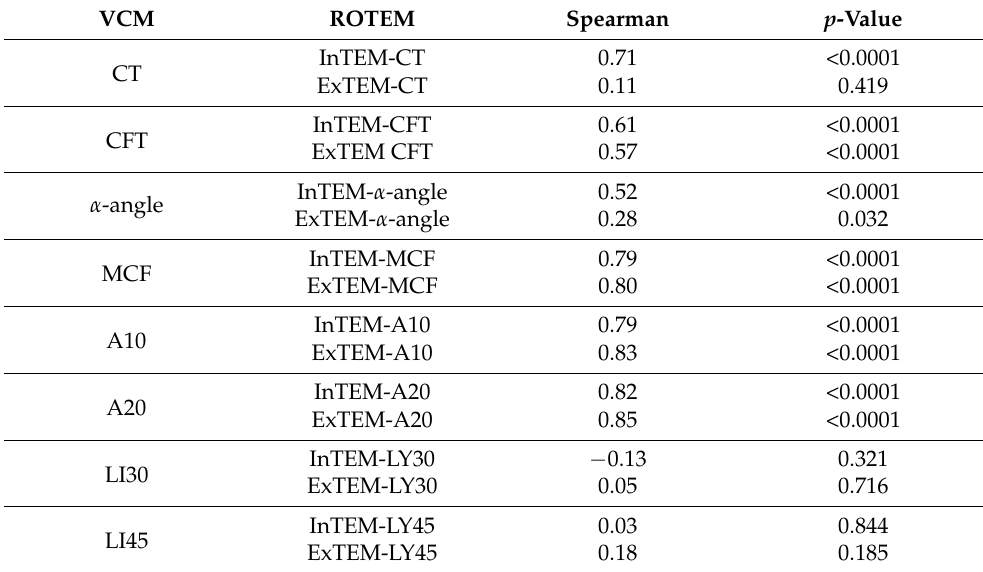
Table 4. Spearman correlations between equivalent ROTEM and VCM parameters of 60 dogs.